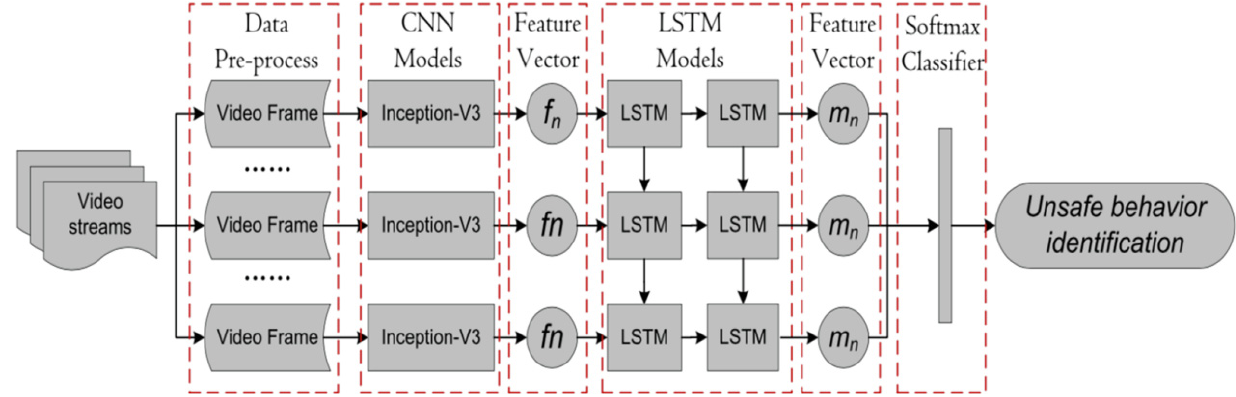
Figure 4. Example of using CNN-LSTM model to identify worker unsafe behavior. Reproduced with permission from ref. [30]. Copyright 2018 Elsevier.